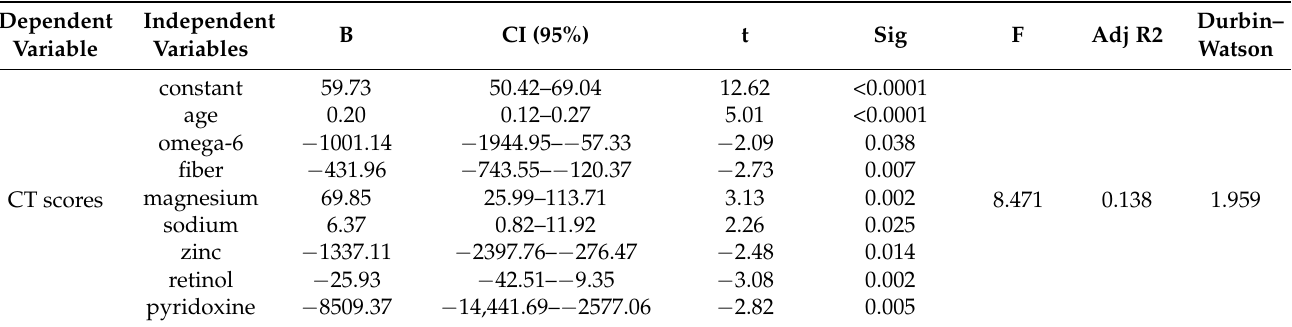
Table 3. Final predictive model for estimation of the CT